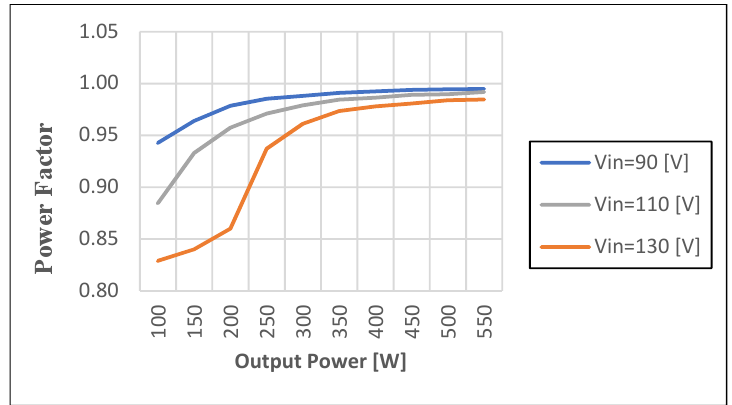
Figure 11. Laboratory practical power factor measurements.